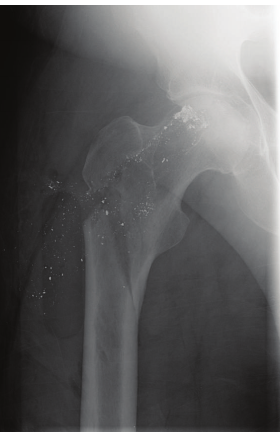
Figure 3: Postoperative day 1 right hip radiograph demonstrating a subtrochanteric femur fracture after the patient rolled in bed and heard a “crack.”